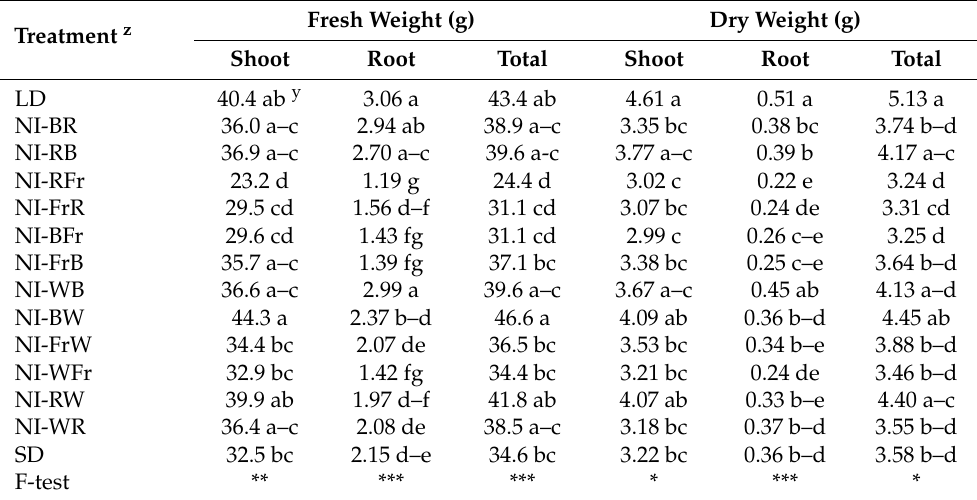
z Please refer to Figure 1 for detailed NIL qualities. y Mean separation within columns by Duncan’s multiple range test at 5% level. *, **, ***: Significant at p ≤ 0.05, 0.01, or 0.001, respectively. Means accompanied by different letters are significantly different ( p <